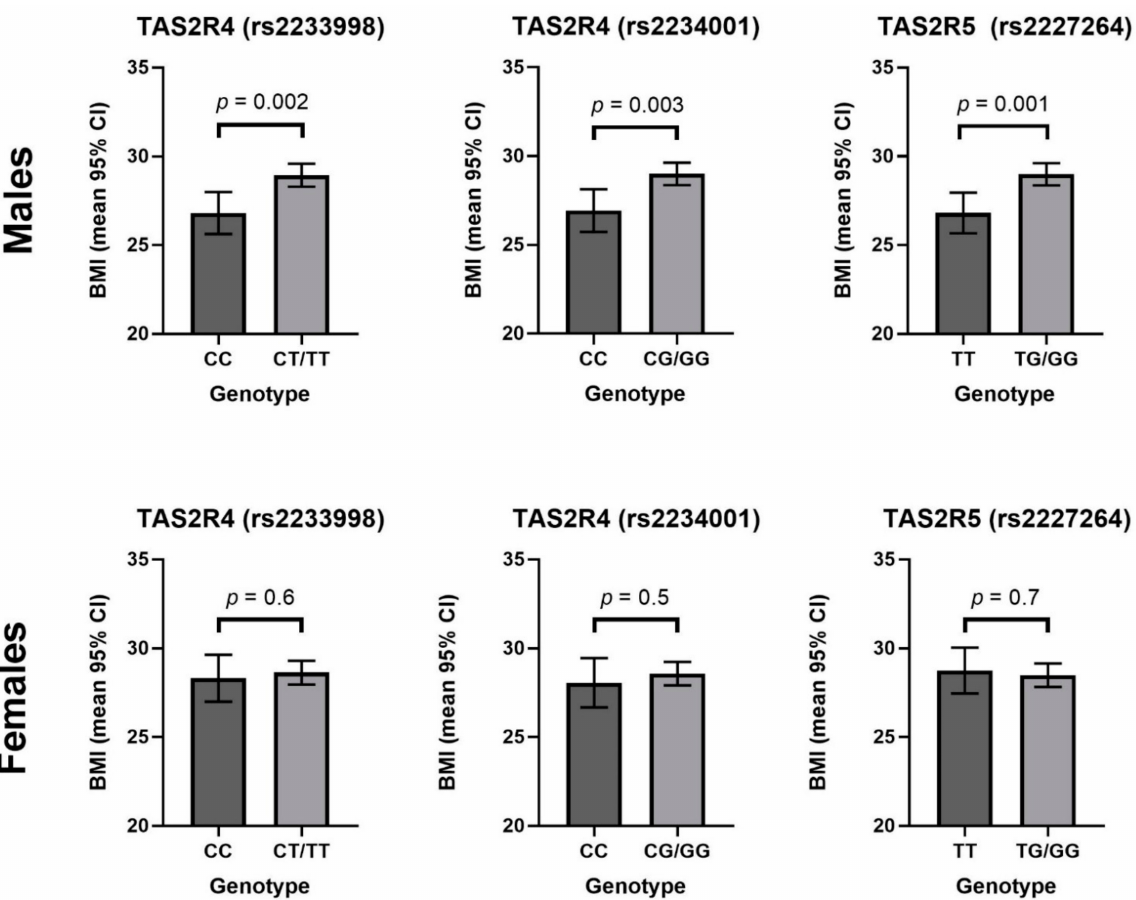
Figure 2. The relationship between TAS2R genotype and BMI by sex. Data are presented as the mean BMI with 95% confidence intervals, adjusted for